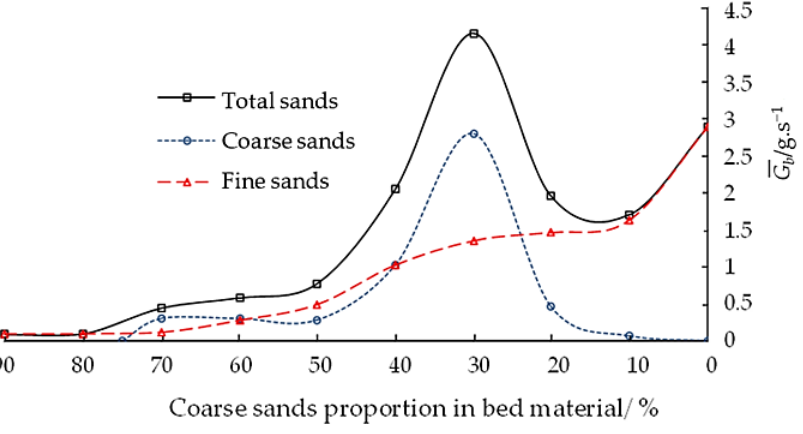
Figure 17. The relationship curves of the average transport rates G b of total bed load sands, fine sands, and coarse sands with the coarse sand proportion of bed material ( Q = 0.026 m³/s, F r = 0.85). The total sand in the figure means the total bed load sands composed of fine and coarse sands. The dashed blue line refers to the changing trend of the transport rate of coarse bed load, while the dashed red line refers to the fine bed load. The figure shows the influence of the fine particles on the transport of differently-sized particles in the mixture and the whole bed